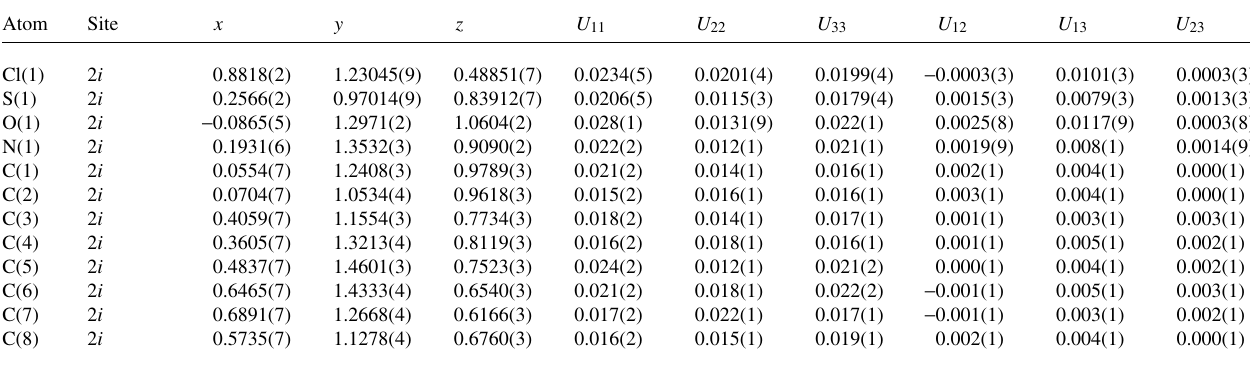
Table 3. Atomic coordinates and displacement parameters (in Å 2 )